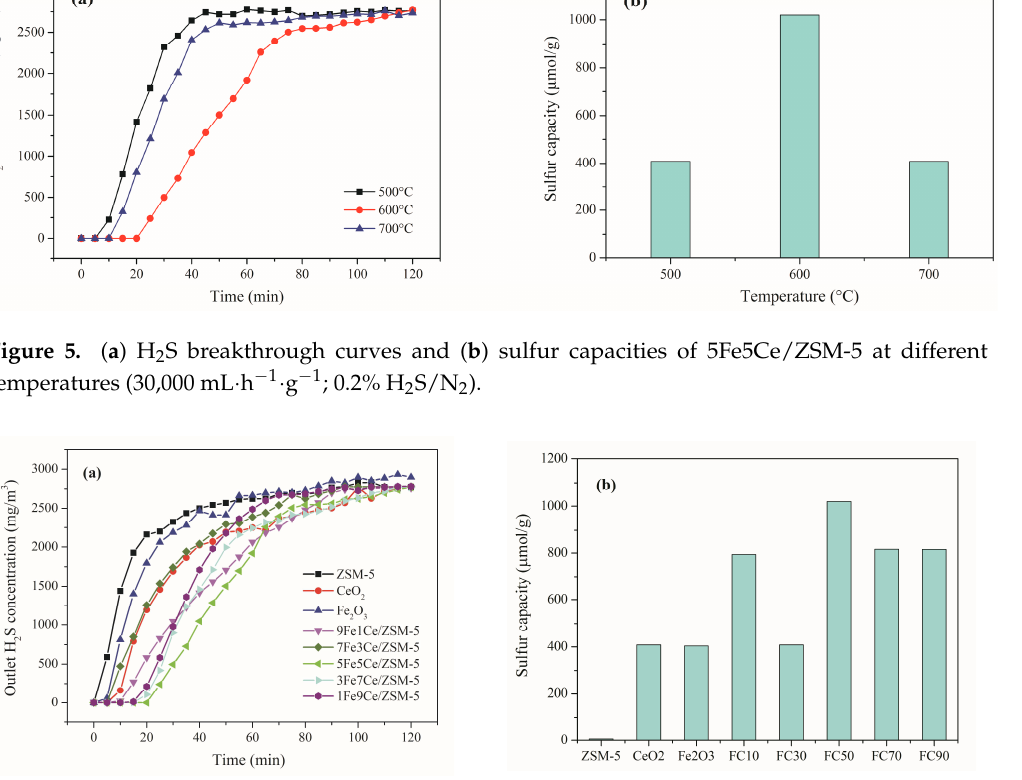
Figure 6. ( a ) H 2 S breakthrough curves and ( b ) sulfur capacities of x Fe y Ce/ZSM-5 with various CeO 2 contents (600 °C; 30,000 mL·h −1 ·g −1 ; 0.2% H 2 S/N 2 ).